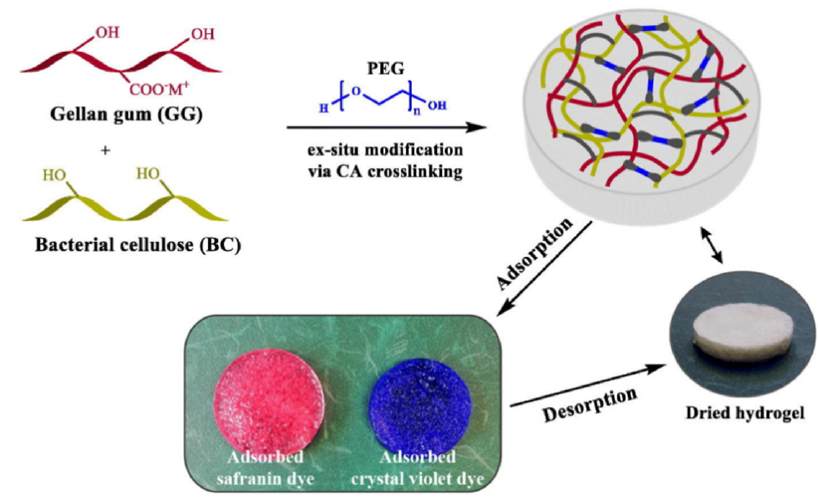
Figure 12. The main interaction for the adsorption of dyes by gellan gum-based adsorbent and the state of adsorbent before and after dye adsorption [237].